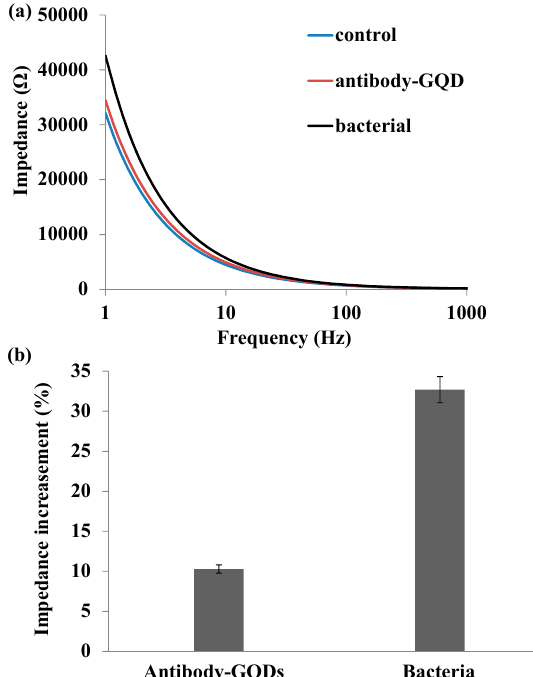
Figure 4. ( a ) Impedance spectra and ( b ) impedance amplitude change of nanoporous alumina membrane immobilized with antibody-GQDs conjugation and bacteria capture.